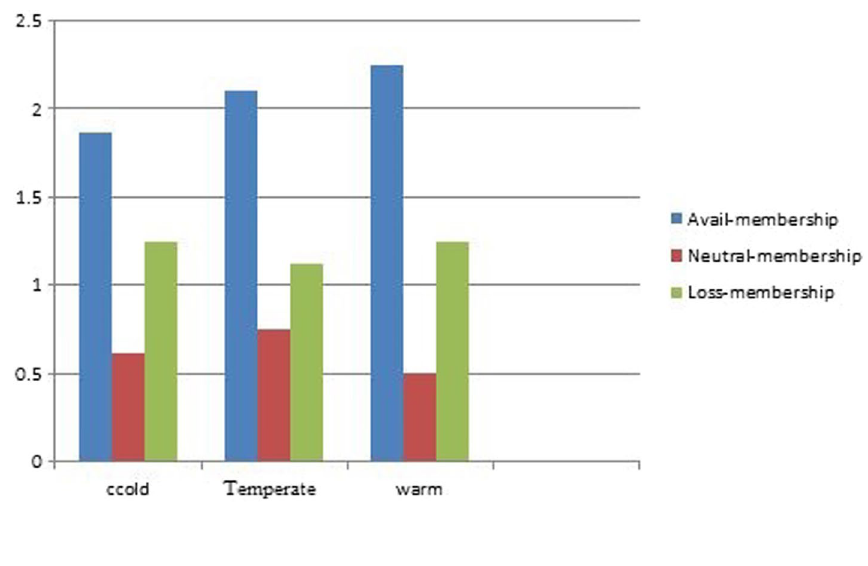
Fig. 11 Comparison of SLE of